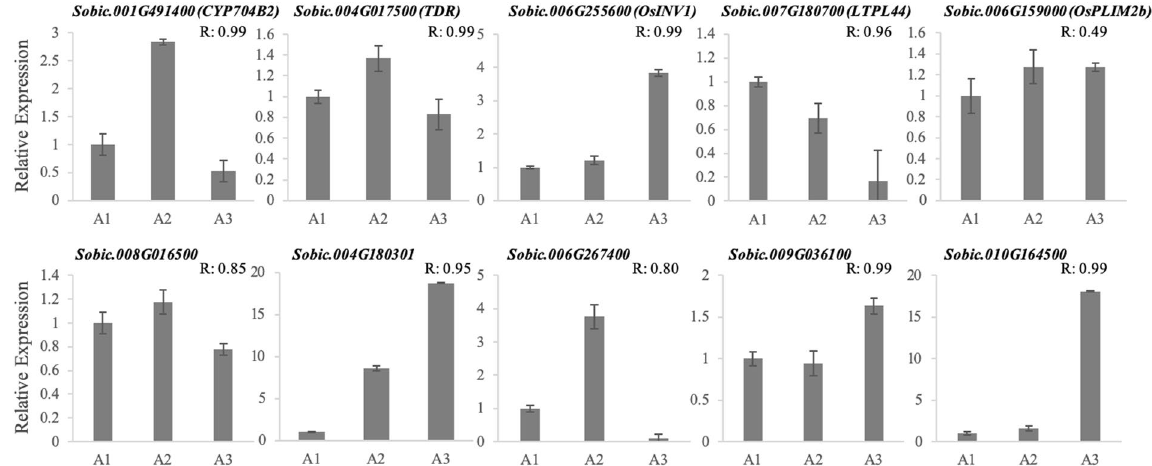
Figure 5. Relative expression of ten genes in anther stages measured by qRT-PCR. Expression of ten genes exhibiting varied expression patterns in RNA sequencing data was analyzed using qRT-PCR. The locus IDs of genes are given on the top with corresponding rice orthologs (if characterized). The Pearson’s correlation coefficient (R) value for each gene indicating correlation between qRT-PCR and RNA-seq data is given on the top right corner.